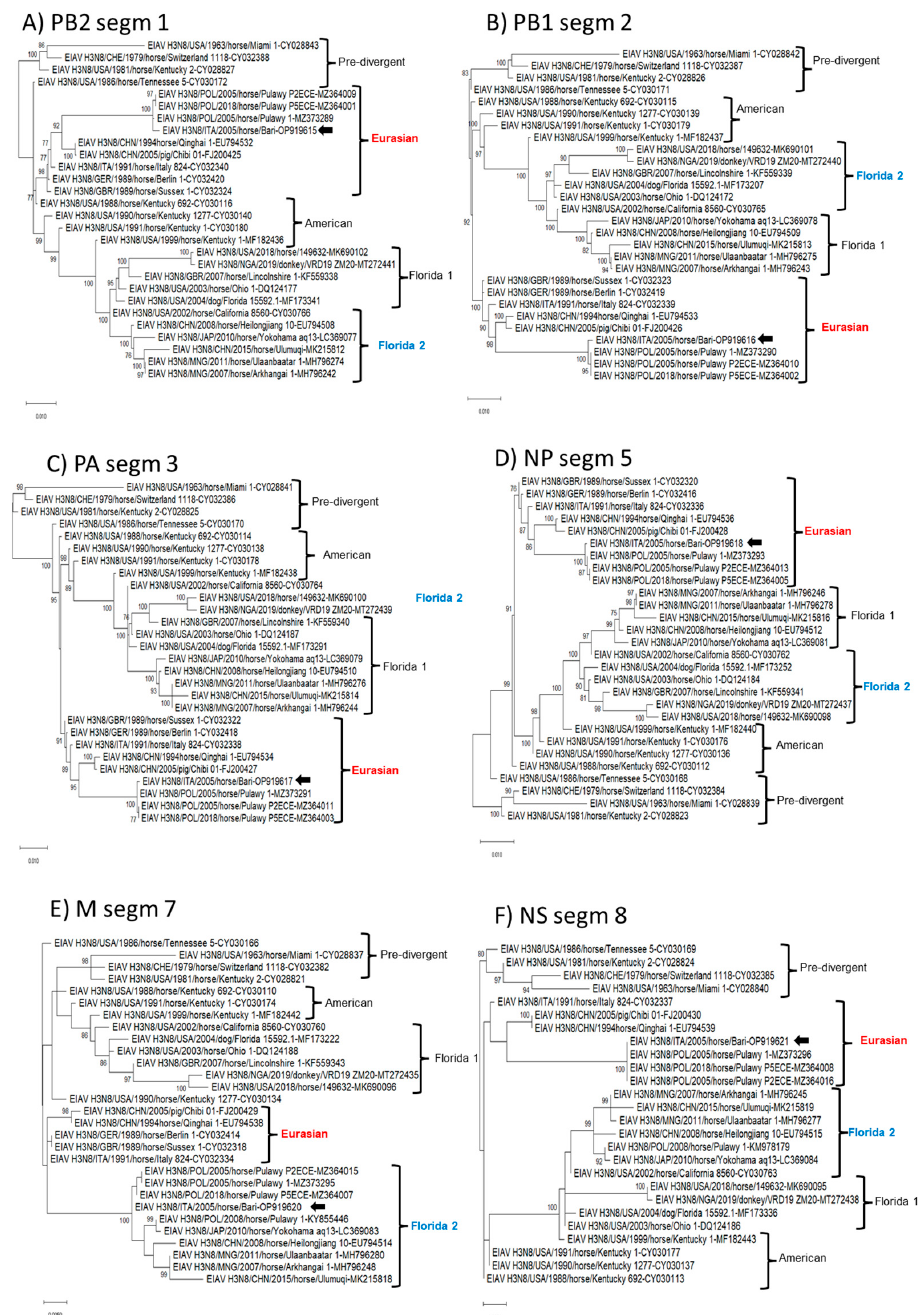
Figure 3. Phylogenetic tree of influenza virus polymerase complex (Polymerase basic protein 2, PB2, Polymerase basic protein 1, PB1, Polymerase acidic, PA), nucleoprotein (NP), matrix protein (M), and non-structural gene (NS) nucleotide sequences of the EIAV subtype H3N8 strain ITA/2005/horse/Bari were compared with cognate sequences retrieved from GenBank database. Phylogeny of PB2 gene ( A ). Phylogeny of PB1 gene ( B ). Phylogeny of PA gene ( C ). Phylogeny of NP gene ( D ). Phylogeny of M gene ( E ). Phylogeny of NS gene ( F ). Phylogenetic trees were performed using the maximum likelihood method and Hasegawa–Kishino–Yano 2-parameter model with a gamma distribution. A total of 1000 bootstrap replicates were used to estimate the robustness of the individual nodes on the phylogenetic tree. Bootstrap values greater than 75% were indicated. Black arrow indicates the strain described in this study. Numbers of nucleotide substitutions are indicated by the scale bar .